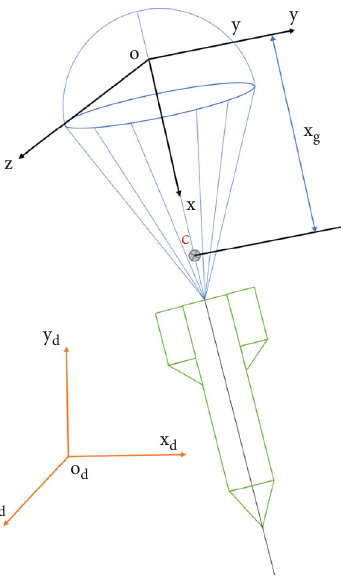
Figure 1: Coordinate system